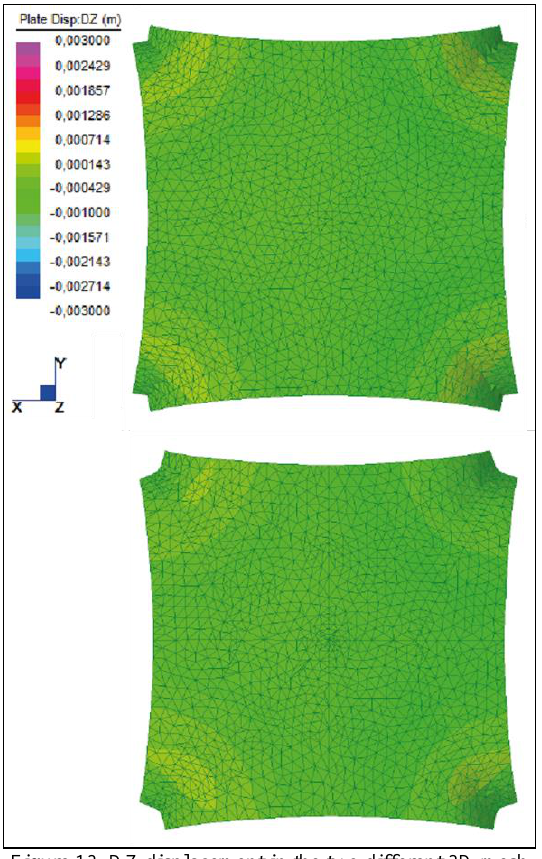
Figure 13. DZ displacement in the two different 3D mesh models: on the left applied to the surface deriving from algorithmic modelling and on the right to the surface commonly derived from the point cloud